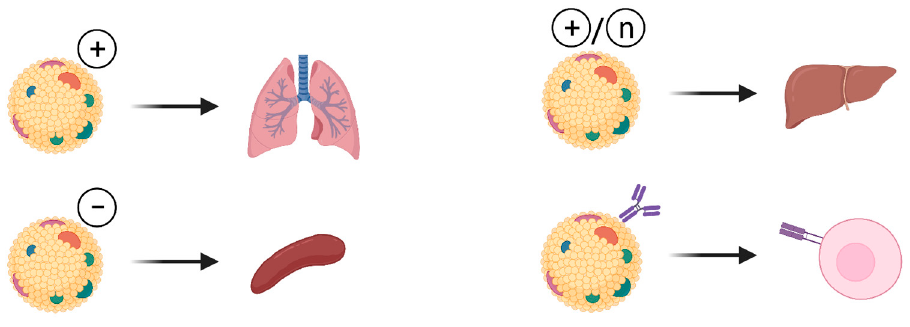
Figure 2 . Approaches for organ specific modifications of LNPs used for RNA delivery .